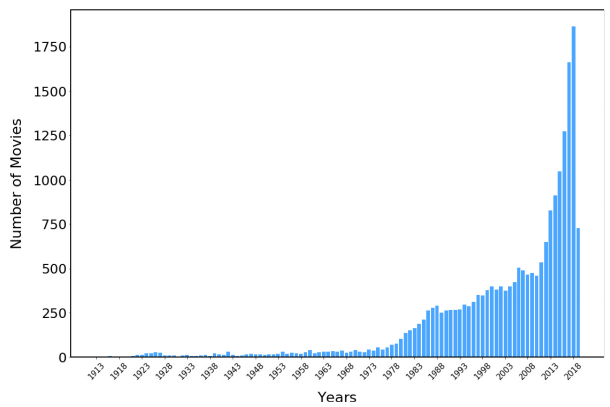
Figure 3. Number of movies by year in our